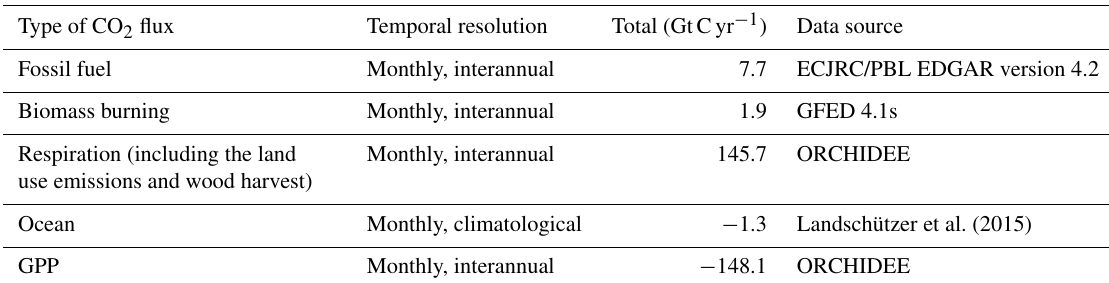
Table 3. Prescribed CO 2 surface fluxes used as model input. Mean magnitudes of different types of fluxes are given for the period